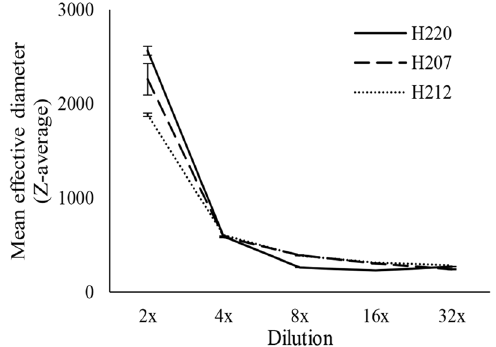
Figure 3. The change in a mean hydrodynamic diameter (Z-average) for dark, buckwheat honey (H220), medium-color canola/willow mixed honey (H207) and light, wildflower honey (H212) as a function of